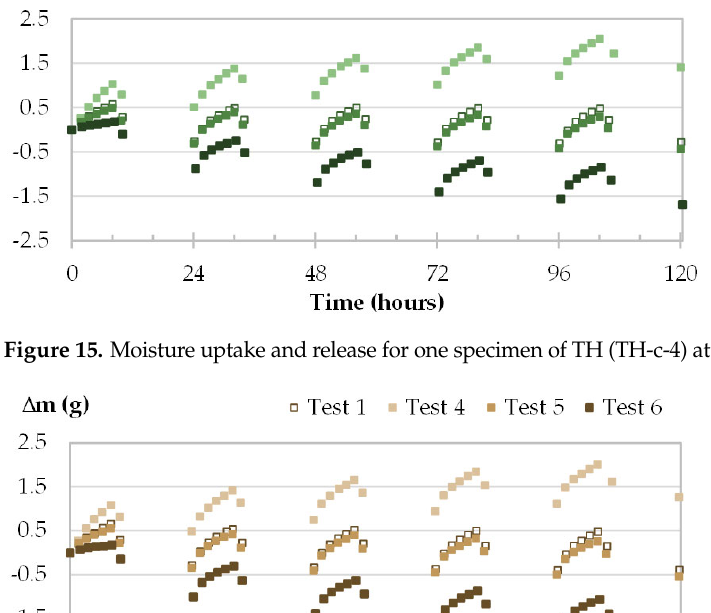
Figure 14. Moisture uptake and release for one specimen of CC (CC-c-1) at different initial conditioning.